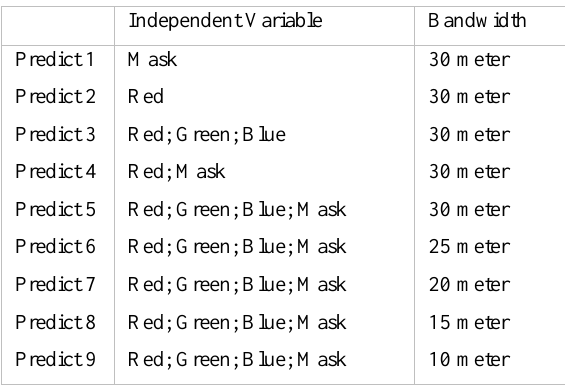
Table 1. Parameters in GWR Model